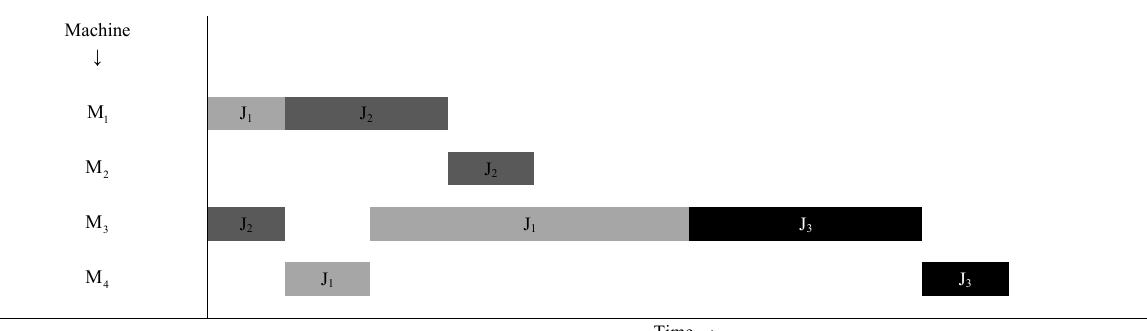
Fig. 1. Decoding of both chromosomes and evaluation of the resulting solution, f 1 : 10 and f 2 : 97